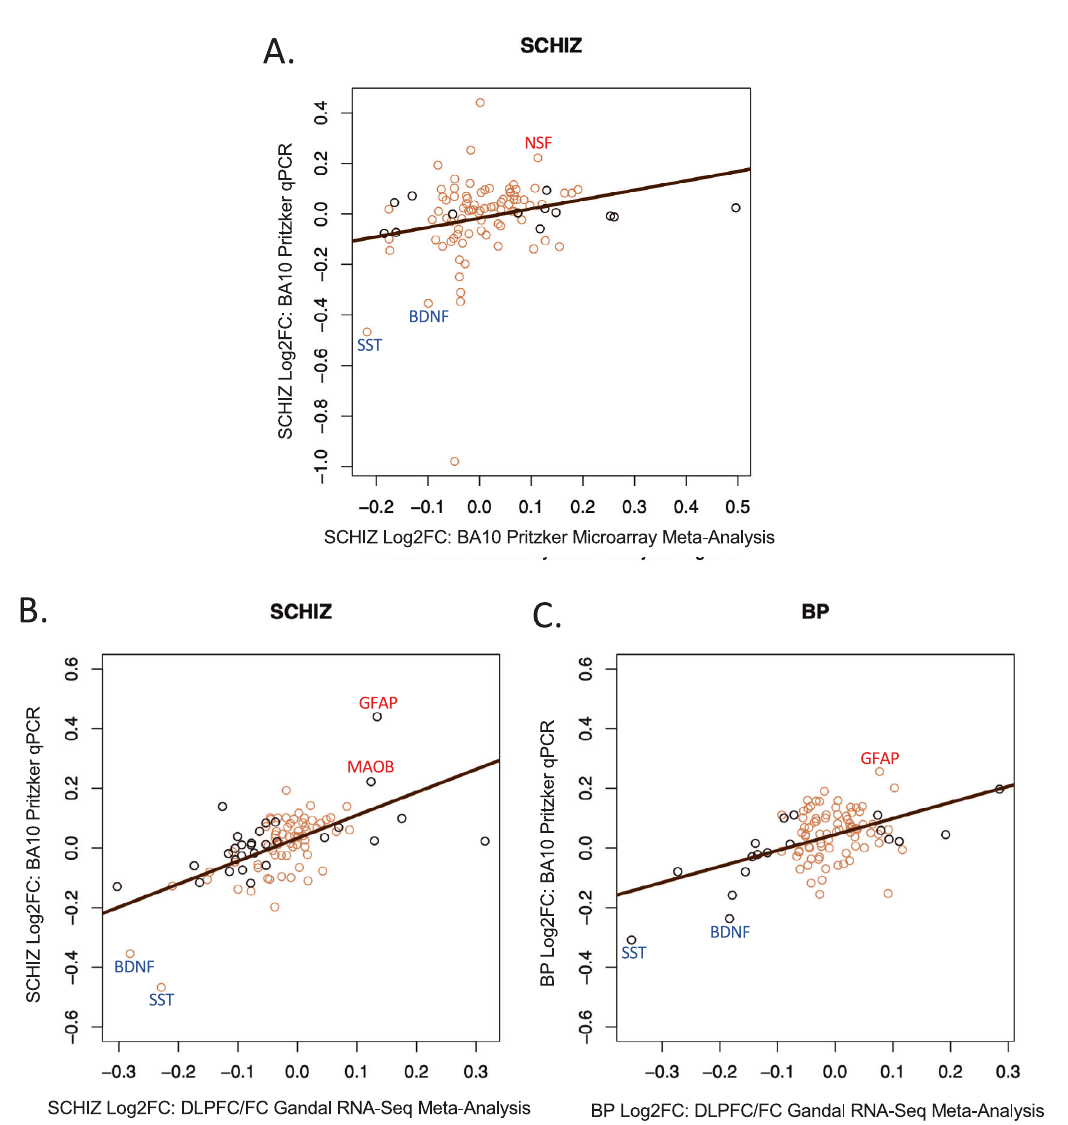
Fig. 2 Our BA10 qPCR experiment replicated many diagnosis effects observed in the frontal cortex in meta-analyses of differential expression results from less sensitive transcriptional pro fi ling methods (microarray, RNA-Seq). In addition to detecting novel diagnosis effects in low-level expressed genes (HTR2B, DRD4), our BA10 qPCR experiment was able to detect diagnosis effects that were observed in the frontal cortex within our current meta-analysis of previous BA10 microarray studies and in a previously-published meta-analysis of RNA-Seq studies of adjacent frontal cortex. A To provide a more robust comparison, we re-annotated and re-analyzed two publicly available BA10 microarray datasets (Iwamoto et al. [20] and Maycox et al. [21]) and then performed a meta-analysis to identify the differential expression associated with SCHIZ. A scatterplot is shown illustrating the positive correlation ( R = 0.243, P = 0.0175) between the differential expression (Log2FC) associated with SCHIZ in our BA10 microarray meta-analysis and the differential expression associated with SCHIZ in our BA10 qPCR experiment (Log2FC) for all genes that were present in both datasets ( n = 95). The color of the data points signi fi es whether a gene showed a nominally signi fi cant effect of diagnosis in the microarray meta-analysis results (black: P < 0.05, brown: P > 0.05). B A scatterplot illustrating the positive correlation ( R = 0.607, P = 6.604e-11) between the differential expression associated with SCHIZ (Log2FC) identi fi ed in a large ( n = 384: 203 CTRL, 181 SCHIZ) meta-analysis of RNA-Seq data from the DLPFC and other frontal cortical (FC) tissue (Gandal et al. [34]) and the differential expression associated with SCHIZ in our BA10 qPCR experiment (Log2FC) for all genes that were present in both datasets (95 genes). The color of the data points signi fi es whether a gene showed a nominally signi fi cant effect of diagnosis in the DLPFC/FC Gandal RNA- Seq meta-analysis results (black: P < 0.05, brown: P > 0.05). C A scatterplot illustrating the positive correlation ( R = 0.490, P = 4.61e-07) between the differential expression associated with BP (Log2FC) identi fi ed in a large ( n = 171: 101 CTRL, 70 BP) meta-analysis of RNA-Seq data from the DLPFC and other frontal cortical tissue (Gandal et al. [34]) and the differential expression associated with BP in our BA10 qPCR experiment (Log2FC) for all genes that were present in both datasets (95 genes). The color of the data points signi fi es whether a gene showed a nominally signi fi cant effect of diagnosis in the DLPFC/FC Gandal RNA-Seq meta-analysis results (black: P < 0.05, brown: P > 0.05). Data points are labeled with of fi cial gene symbols for genes that show particularly large Log2FC in both datasets. Full statistical reporting for the correlations between the differential expression observed in different datasets can be found in Supplementary Table